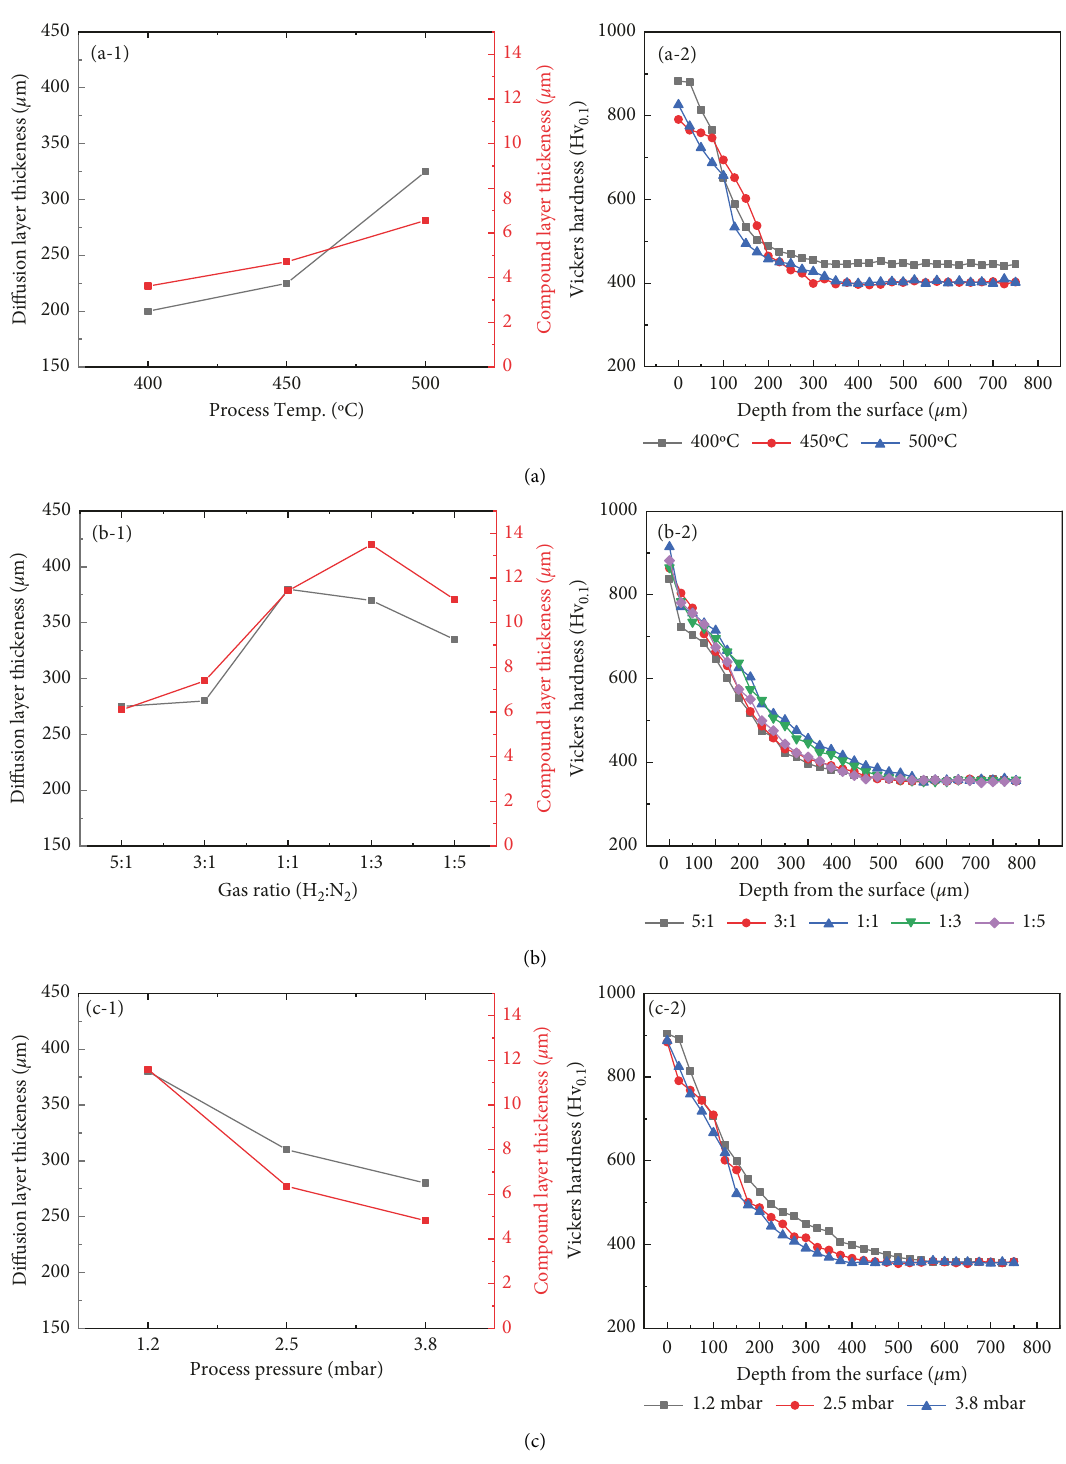
Figure 1: Thickness of compound layer and nitrogen diffusion layer. The first column (a-1, b-1, c-1) represents formed layer thickness, while the second column (a-2, b-2, c-2) represents hardness profiles. From top to bottom, the sequence of the rows is process temperature, process gas ratio, and process